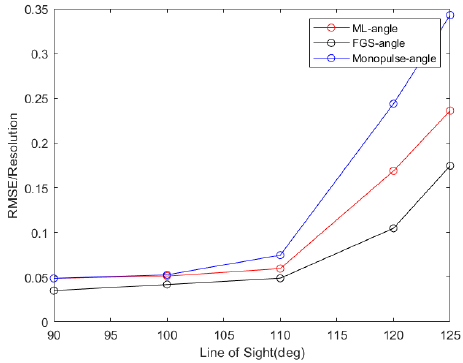
Figure 8. Statistical performance results with the line of sight increasing.